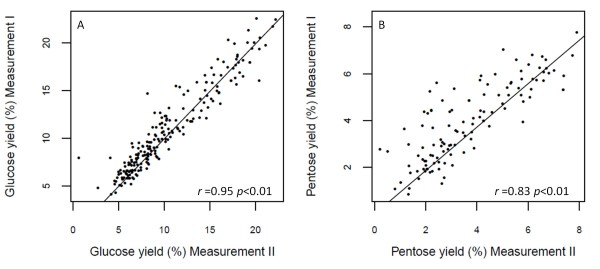
Pearson’s correlation (r) between repeated measurements of cell wall glucose (A) and pentose yield (B). Cell wall glucose and pentose yield (%) correlation between two measurements taken at two different times (eight months apart) was estimated using 211 and 117 samples, respectively.